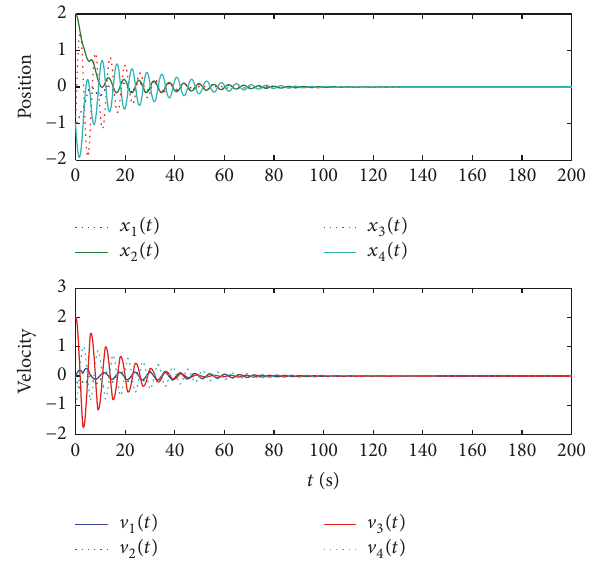
Figure1:Synchronizationwithinitialstates 𝑧(0) = [−1,0, 2,0,−1, 2, −1, −1] 𝑇 .